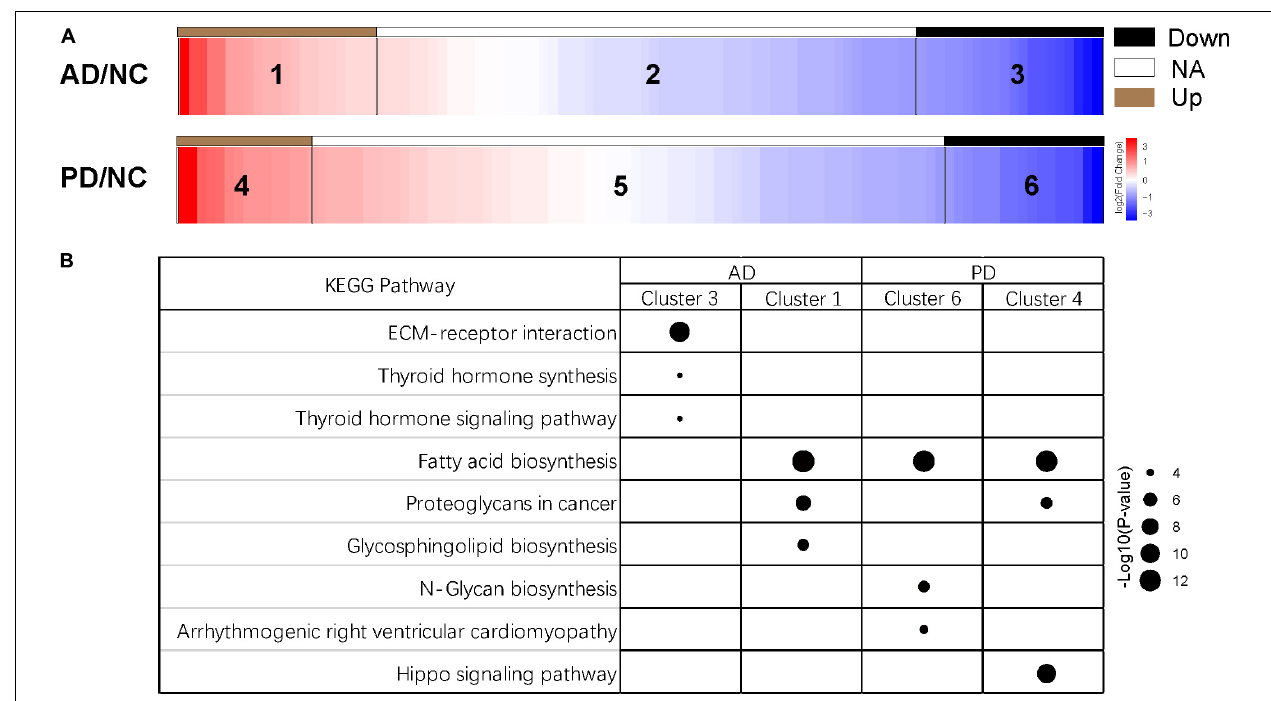
FIGURE 1 | Clusters of miRNA expression and enriched pathways. (A) Heatmap of differentially expressed miRNAs of six clusters. Down, miRNAs with expression of log 2 (AD/NC) or log 2 (PD/NC) < -1; NA, miRNAs with expression of -1 < log 2 (AD/NC) or log 2 (PD/NC) < 1; Up, miRNAs with expression of log 2 (AD/NC) or log 2 (PD/NC) > 1. (B) KEGG pathway of miRNAs from four clusters. Target genes of miRNAs were predicted by miRanda, TargetScan, and RNAhybrid individually. Joint target genes were selected and KEGG pathway enrichment analysis was carried out. Top three pathways of each cluster were shown. The size of the dots represents the -log 10 ( p -value) of each